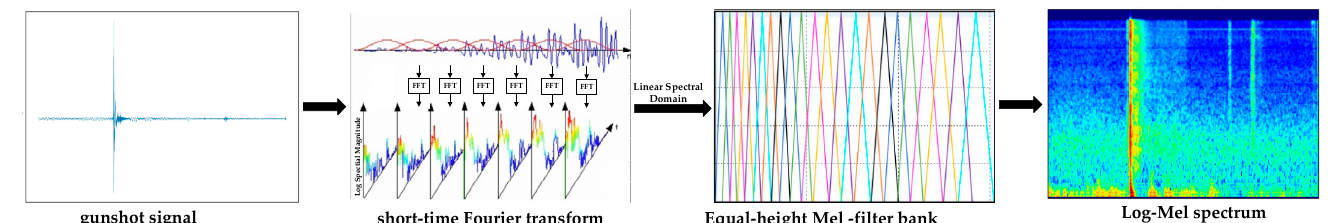
Figure 3. Schematic diagram of the Log-Mel extraction process.